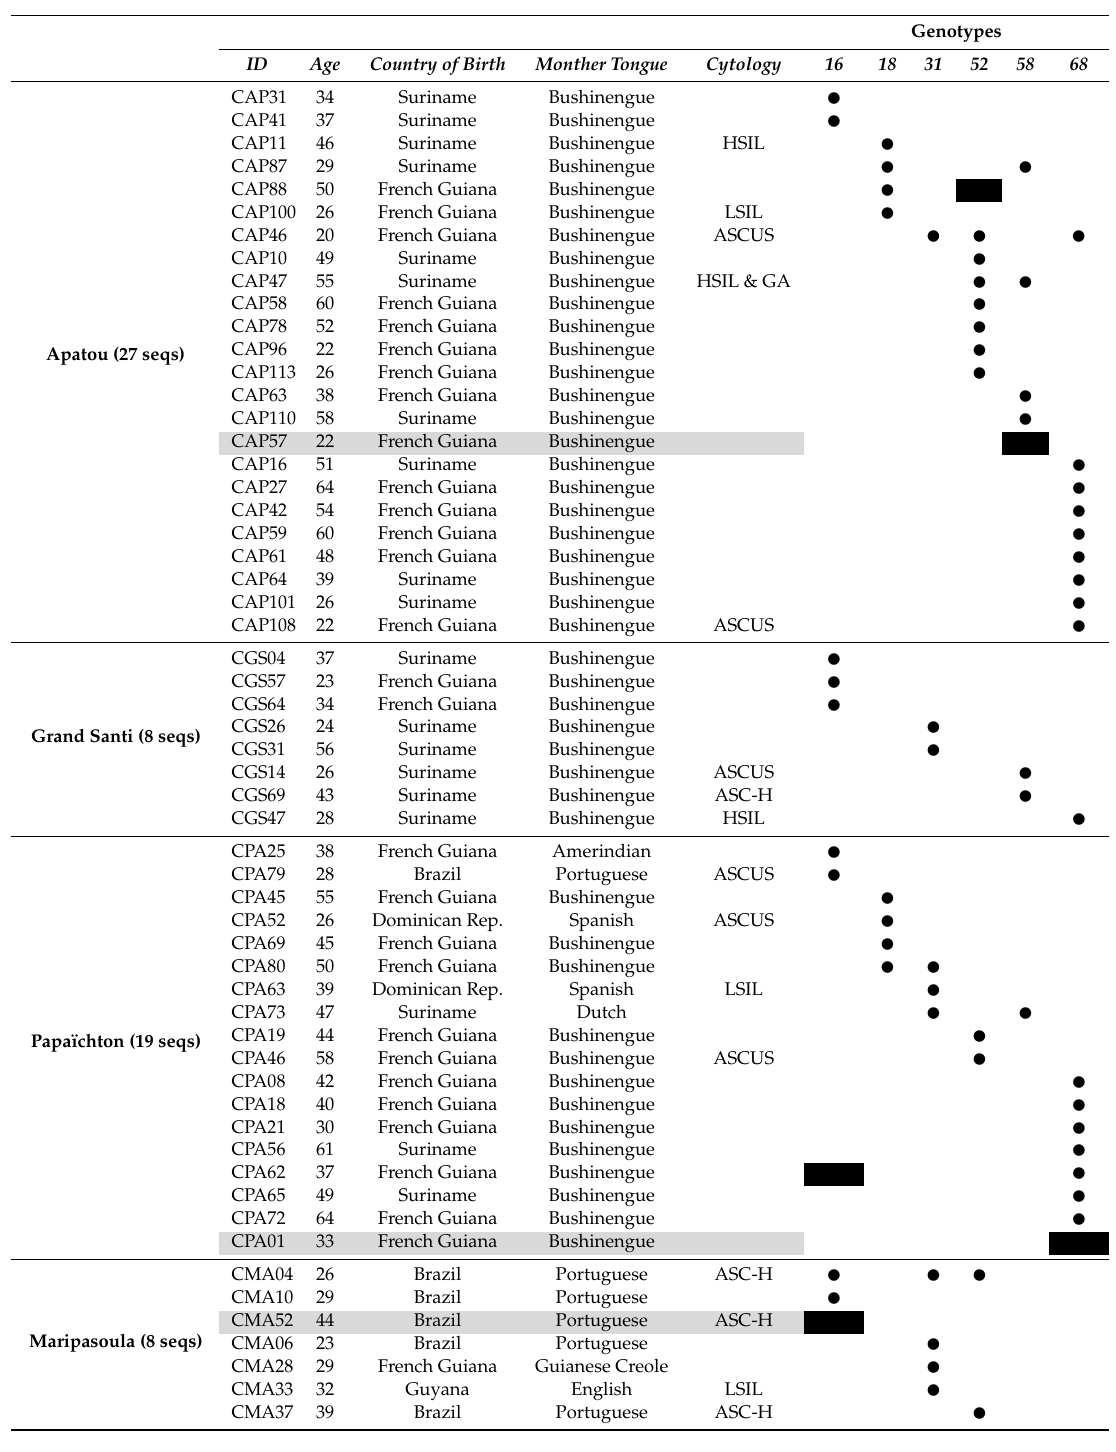
Table 2. HPV genotypes identified on the Maroni, classified by